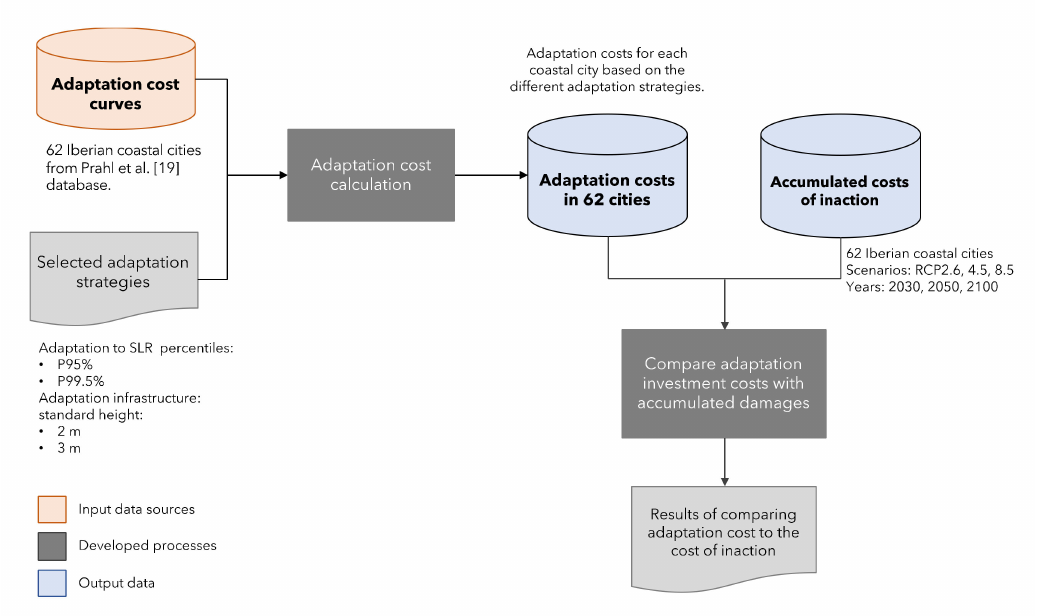
Figure 6. Summary of the methodological approach followed to estimate adaptation investment needs in each city under three sea-level rise scenarios. Investment costs are then compared to the accumulated costs of inaction to assess adaptation